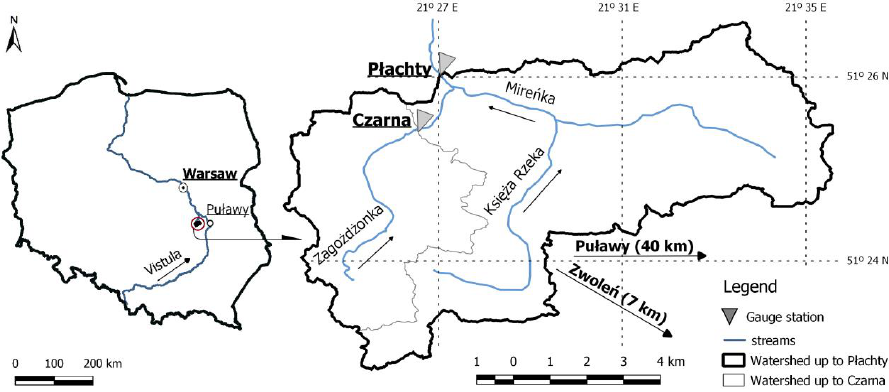
Figure 1. Locality map of the Zagożdżonka River watershed.